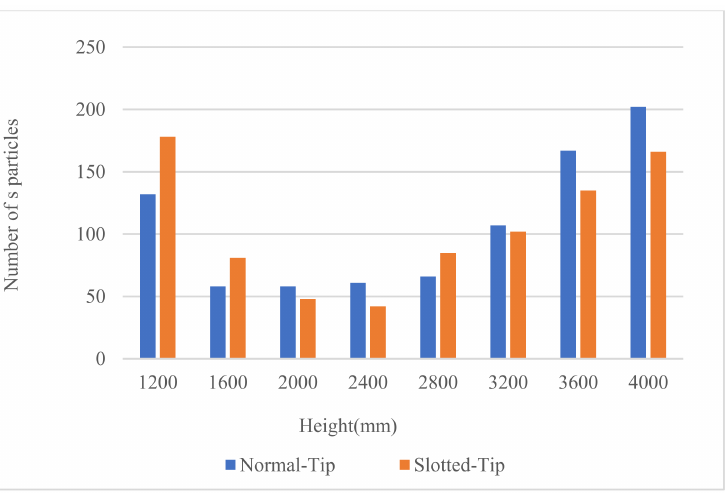
Figure 22. Comparison of particles numbers by height in different blades at 2 s and 2.25